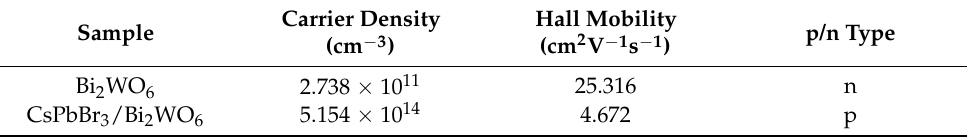
Table 2. Hall effect measurement of pure Bi 2 WO 6 and 15 wt% CsPbBr 3 /Bi 2 WO 6 samples.